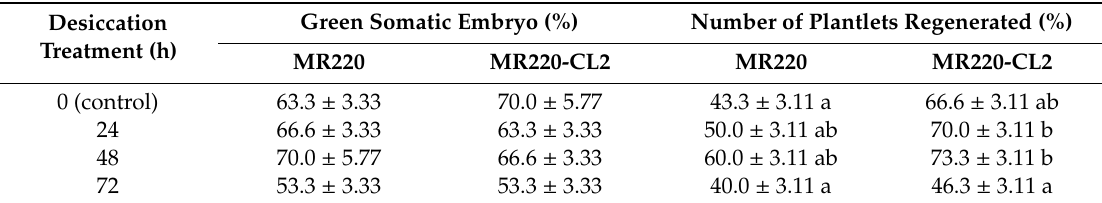
Table 4. The green somatic embryo formation percentage and number of plantlets regeneration in MR220 and MR 220-CL2 cultivars under di ff erent desiccation treatments.